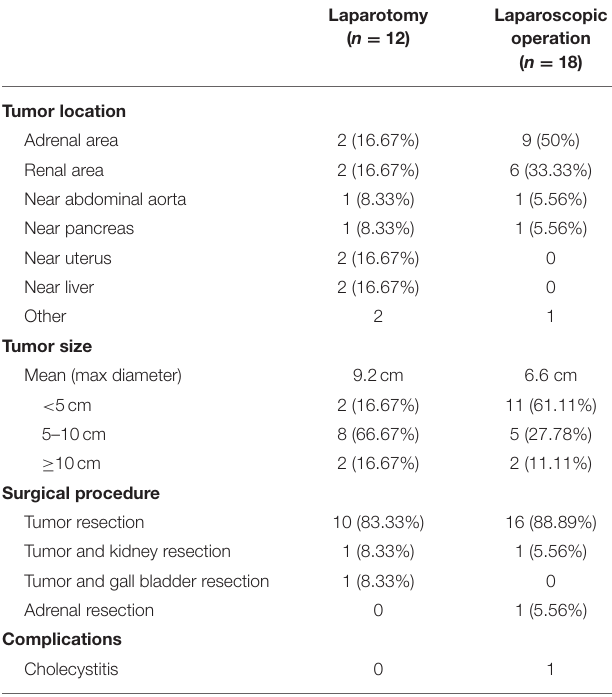
TABLE 5 | Comparison between laparotomy and laparoscopic operation.